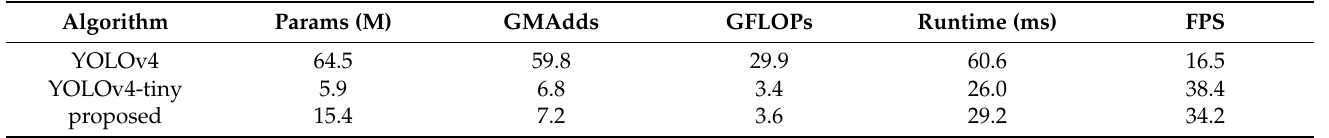
Table 4. The comparison of inference performance on x86-64